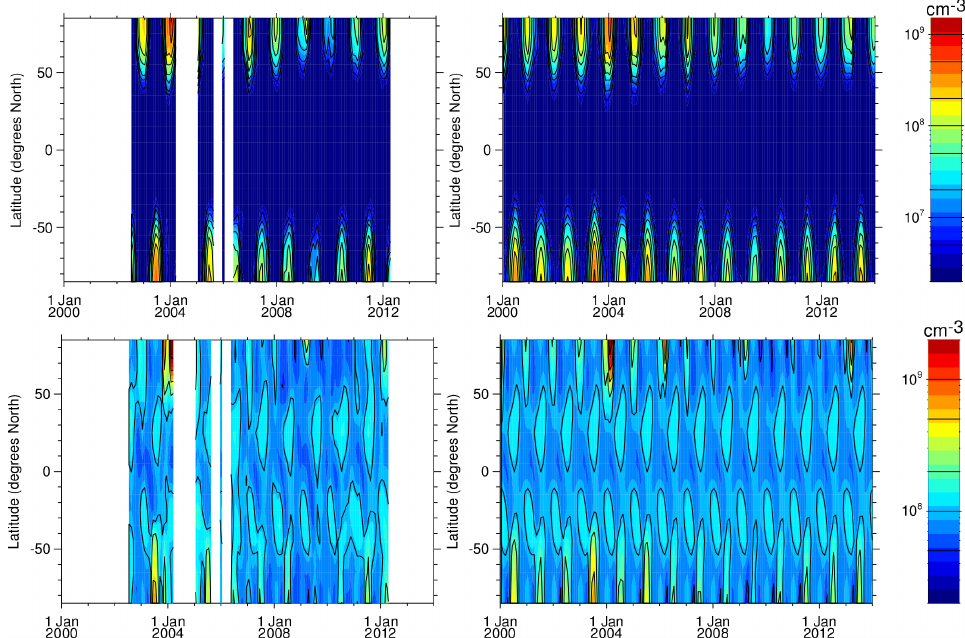
Figure 12. Latitude–time sections of NO y densities observed by MIPAS (left) and from the UBC model (right) at 0.02hPa (top) and 0.5hPa (bottom).